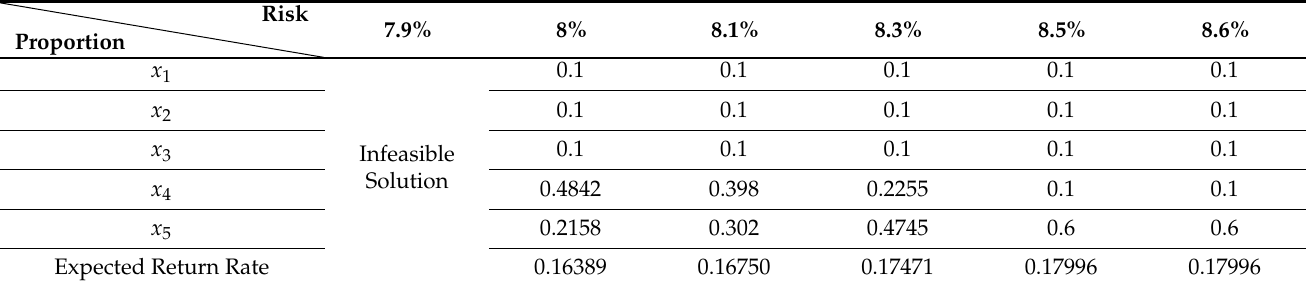
Table 8. The efficient portfolio with s = 3 in a guaranteed return rate (cid:101) p 2 .